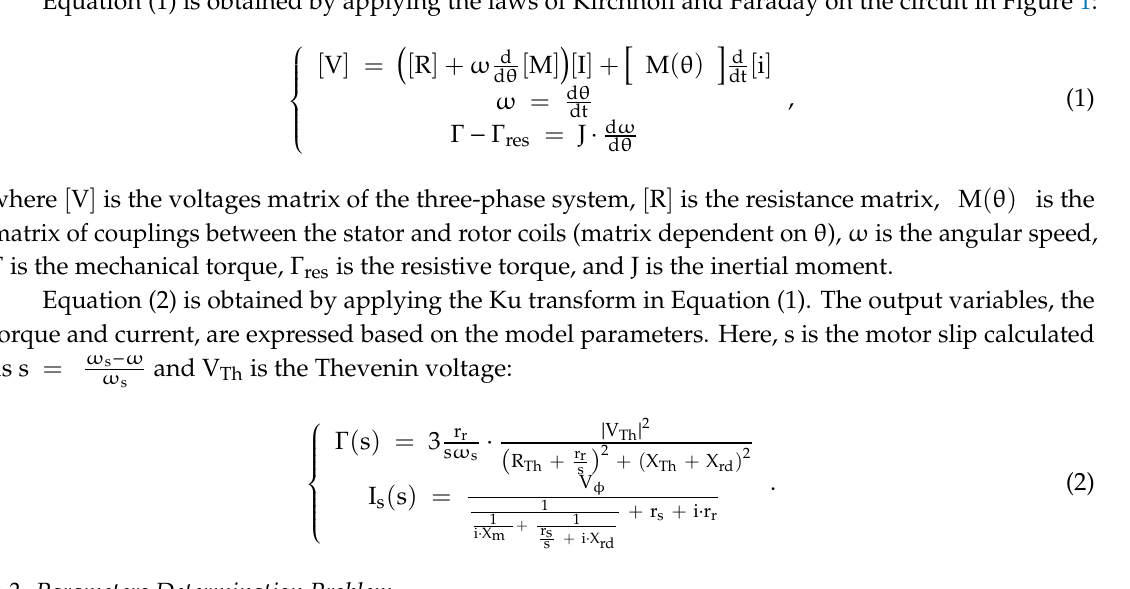
Figure 1. Equivalent electrical circuit of the SC model of the three-phase IM, per phase. Source: ([1] Figures 2 and 3).